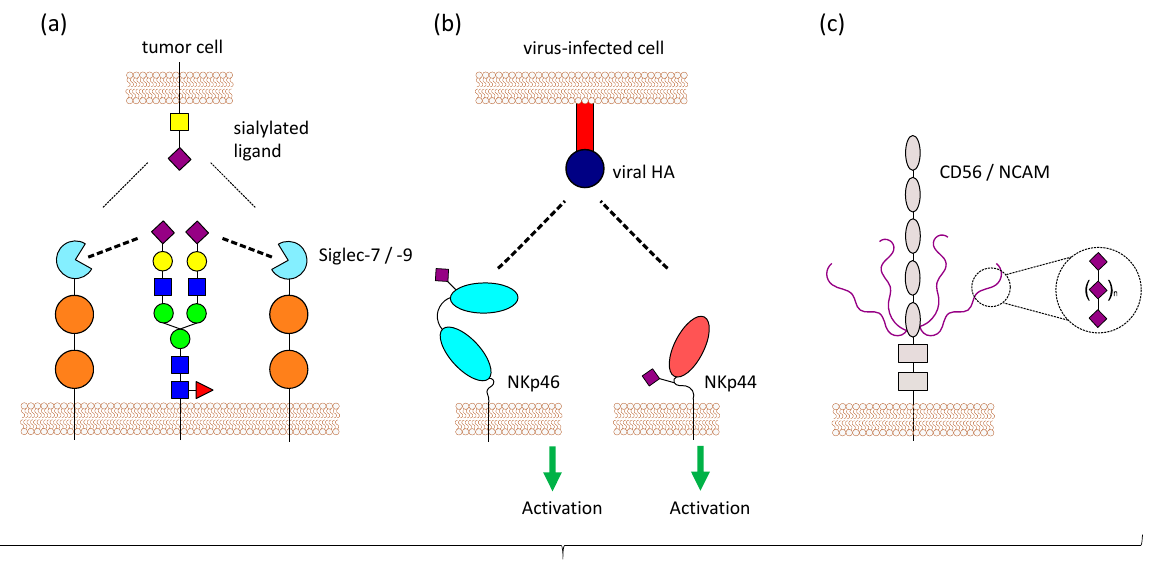
Figure 3. Sialic acids on NK cells. NK cells have sialic acids on their surface, which can influence NK cell functions in different ways. ( a ) Siglecs can not only bind to molecules on other cells (trans), but also to molecules on the same cell (cis). Masking can regulate Siglec function, since trans-ligands have to compete with the masking ligands present on NK cells. ( b ) NKp46 and NKp44 are sialylated, and it has been shown that these activating receptors interact with viral proteins like HA in a sialic acid-dependent manner. Virus-infected cells producing viral HA can be detected by NK cells via NKp44 and NKp46. ( c ) Furthermore, NK cells express CD56/NCAM, which carries a special form of glycosylation called polySia (long chains of sialic acid molecules attached to via α -2,8 linkage). PolySia on NCAM has been well studied in the central nervous system, where it is involved in regulating cell adhesion, but the function of this modification on NK cells is still